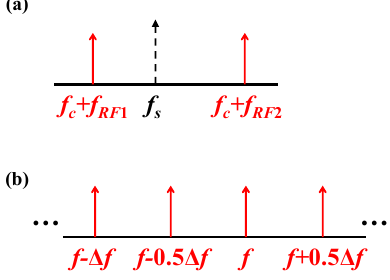
Figure 1. Scheme of proposed all-optical microwave frequency divider.